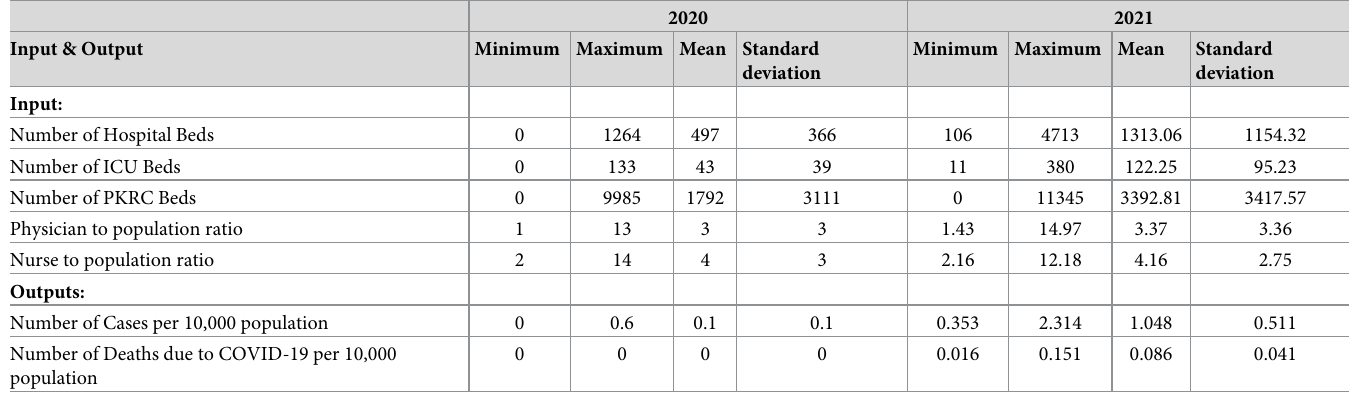
Table 3. Descriptive statistics of inputs and outputs for years 2020 and